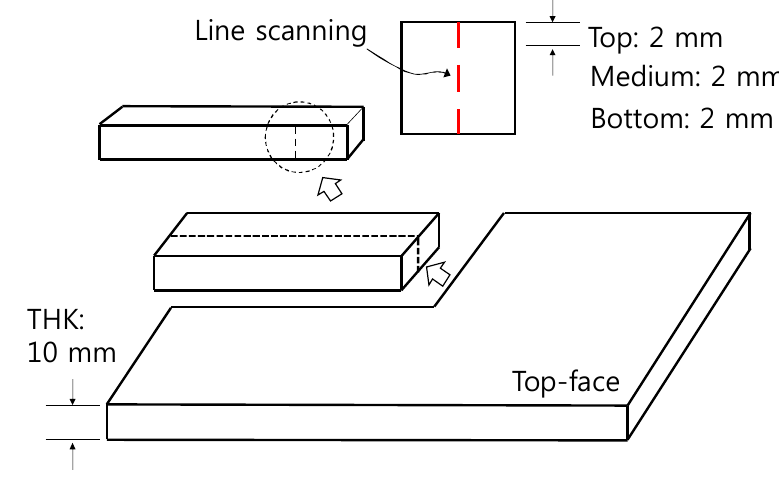
Figure 10. Specimen preparation for low vacuum (LV) SEM analyses: 25 × 10 × 10 mm.